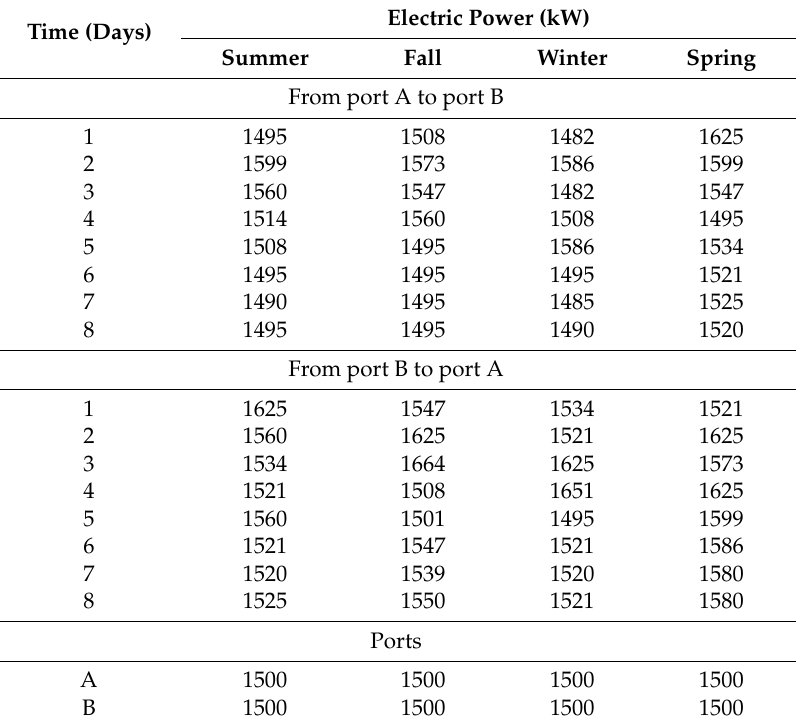
Table 22. Electric power demands for each season.